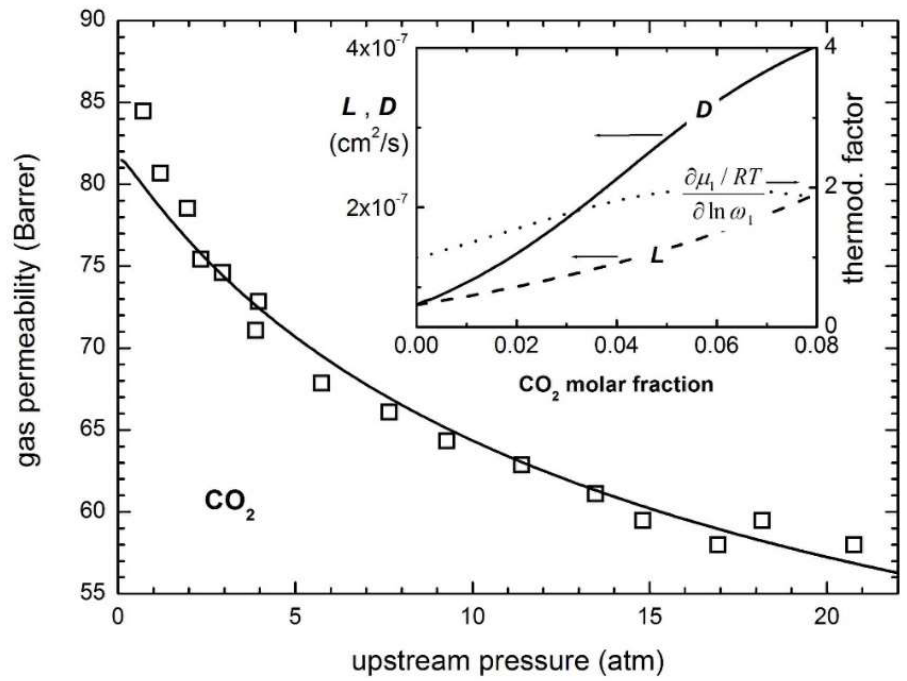
Figure 11. CO 2 permeability in glassy PPO at 35 °C. Experimental data from [241]. The inset illustrates the thermodynamic factor (from NELF model), the mobility coefficient 𝐿 , and the diffusivity 𝐷 as functions of penetrant concentration in the polymer. Reprinted with permission from Ref. [240]. Copyright 2017, Springer.